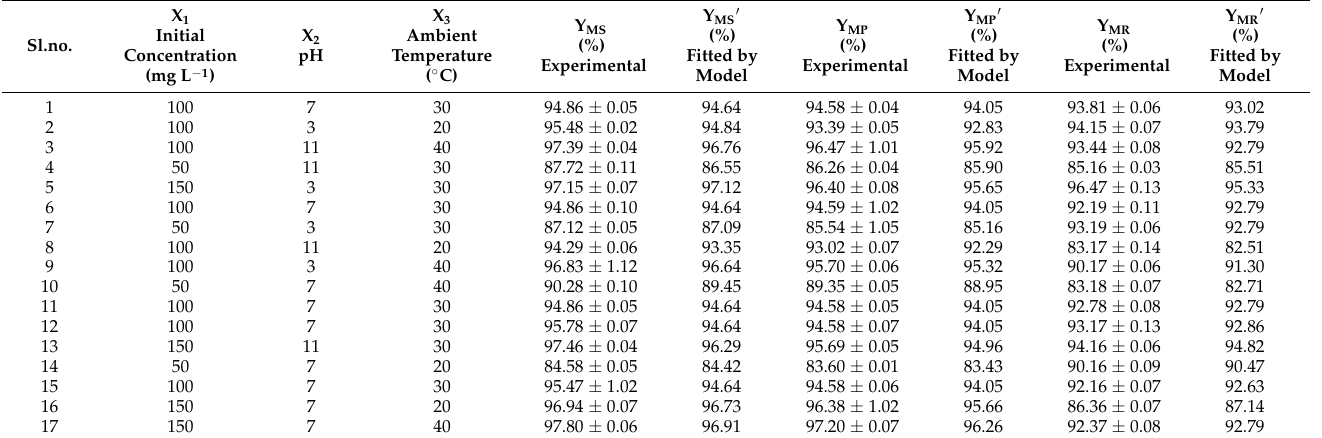
Table 2. Experimental design and the corresponding